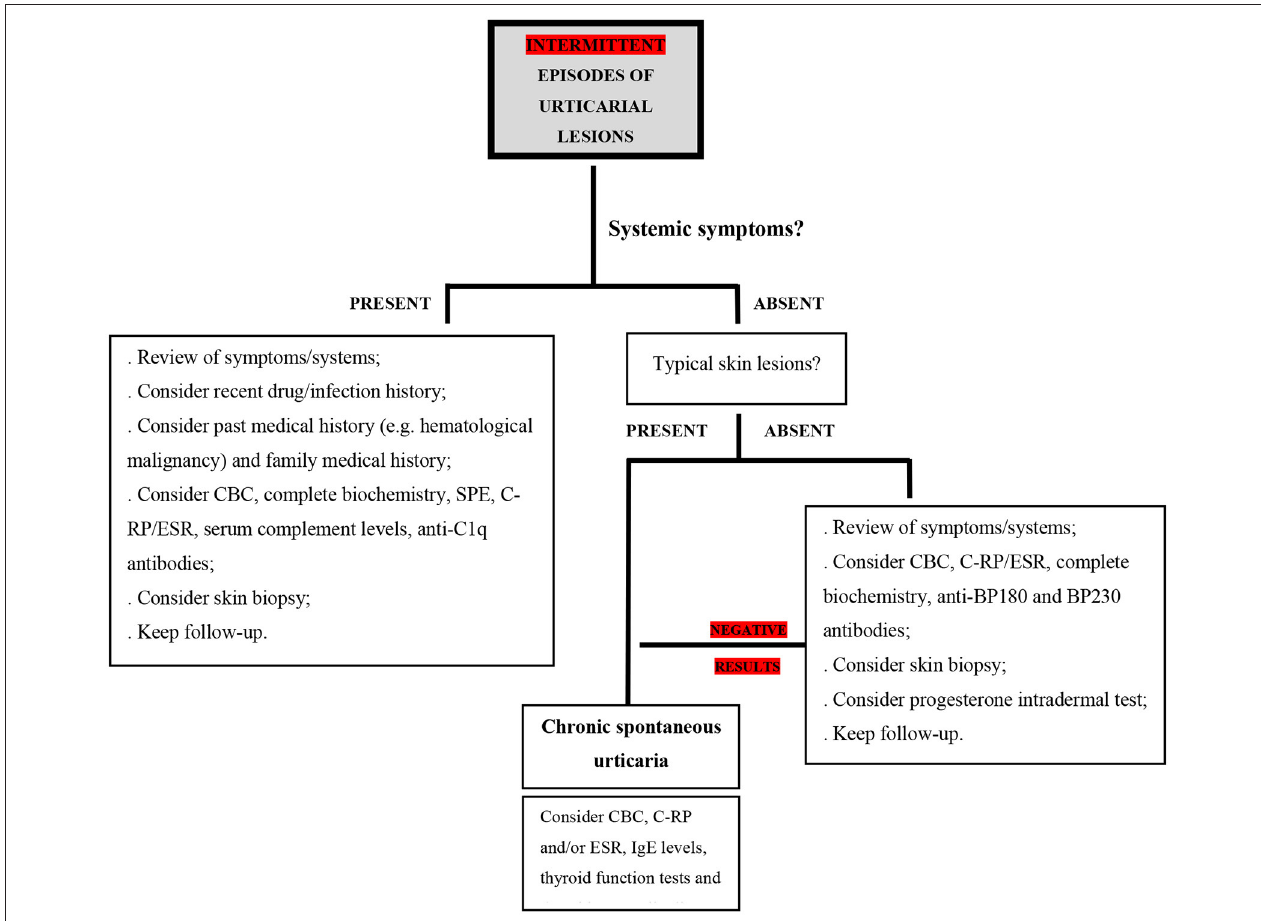
FIGURE 2 | Proposed diagnostic algorithm in the setting of intermittent urticarial lesions; CBC, complete blood count; C-RP, C-reactive protein; ESR, erythrocyte sedimentation rate; SPE, serum protein electrophoresis; IgE, immunoglobulin E; BP180, BP 230 - bullous pemphigoid antigens BP230 and